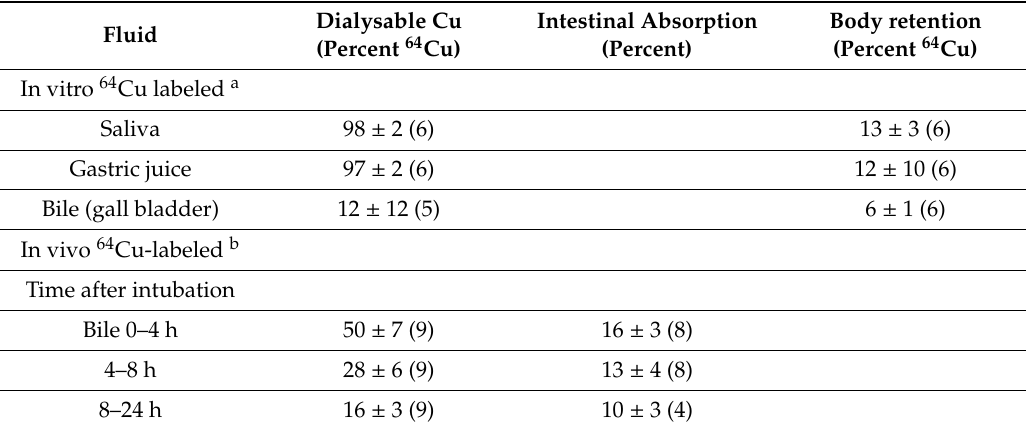
Table 2. Absorption and Dialysability of Cu in GI Tract Fluids of Rats *. Fluid